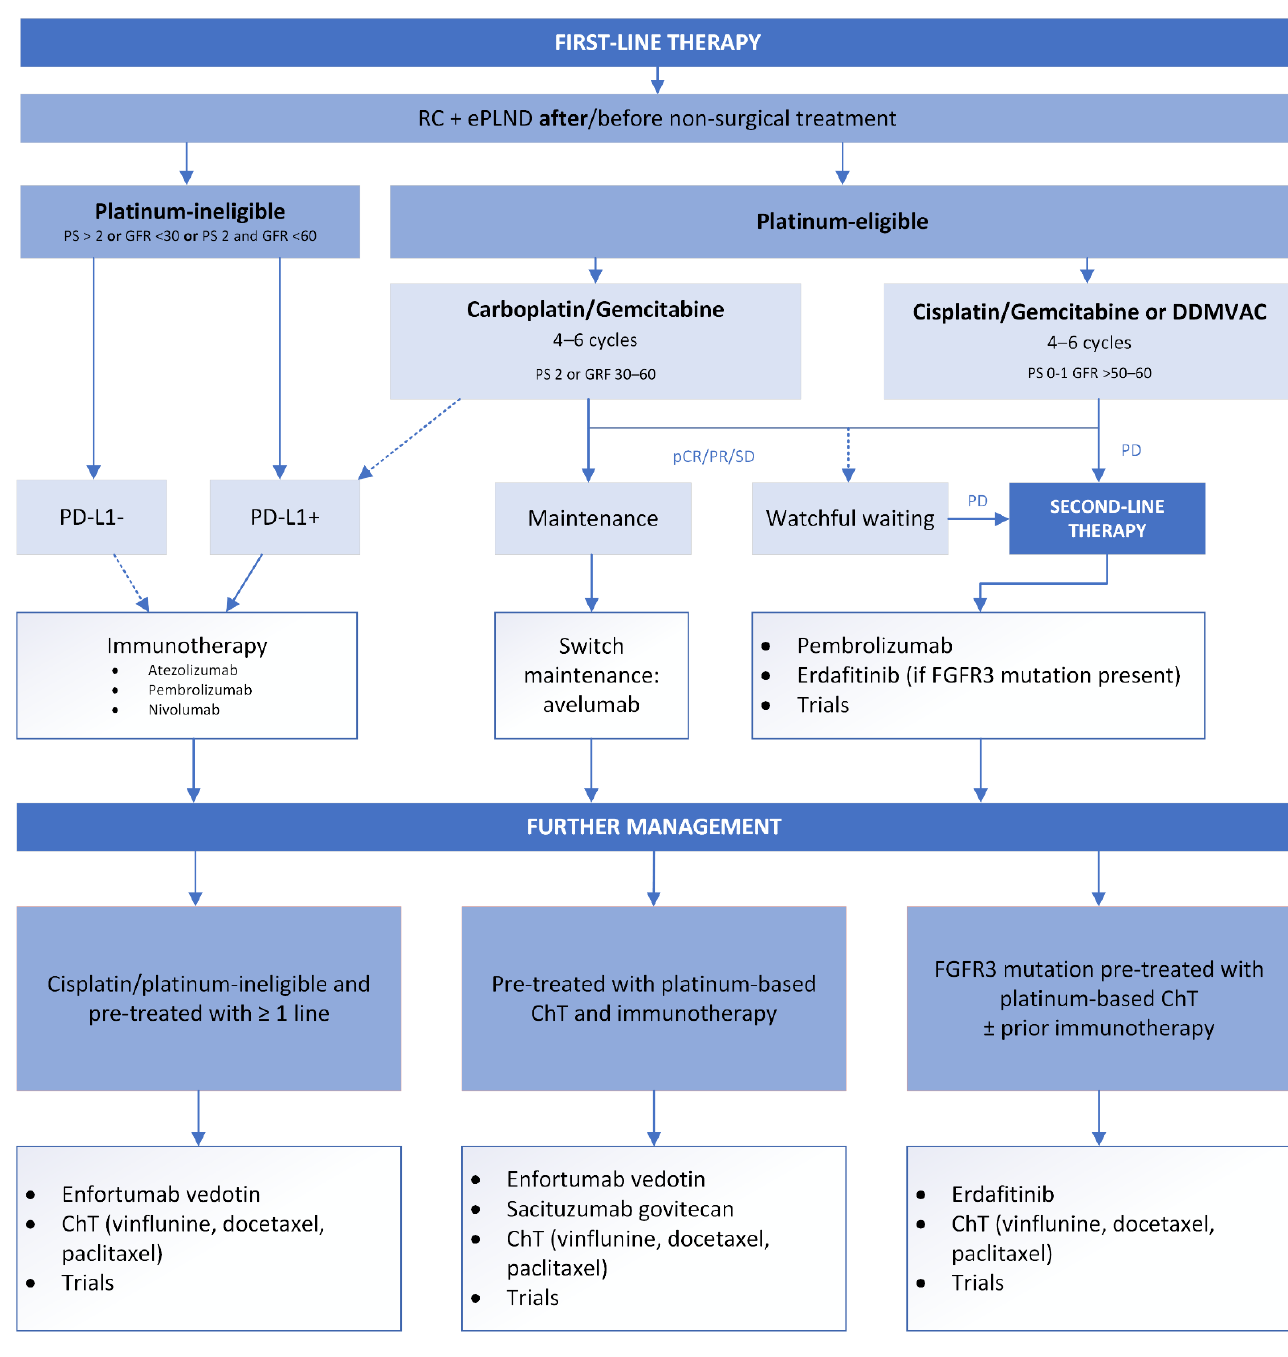
Figure 3. Summary of the management of cN+ patients. FGFR = fibroblast growth factor receptor; GFR = glomerular filtration rate; pCR = pathological complete response; PD = progressive disease; PD-L1 = programmed death-ligand 1; PR = partial response; PS = performance status; SD = stable disease.